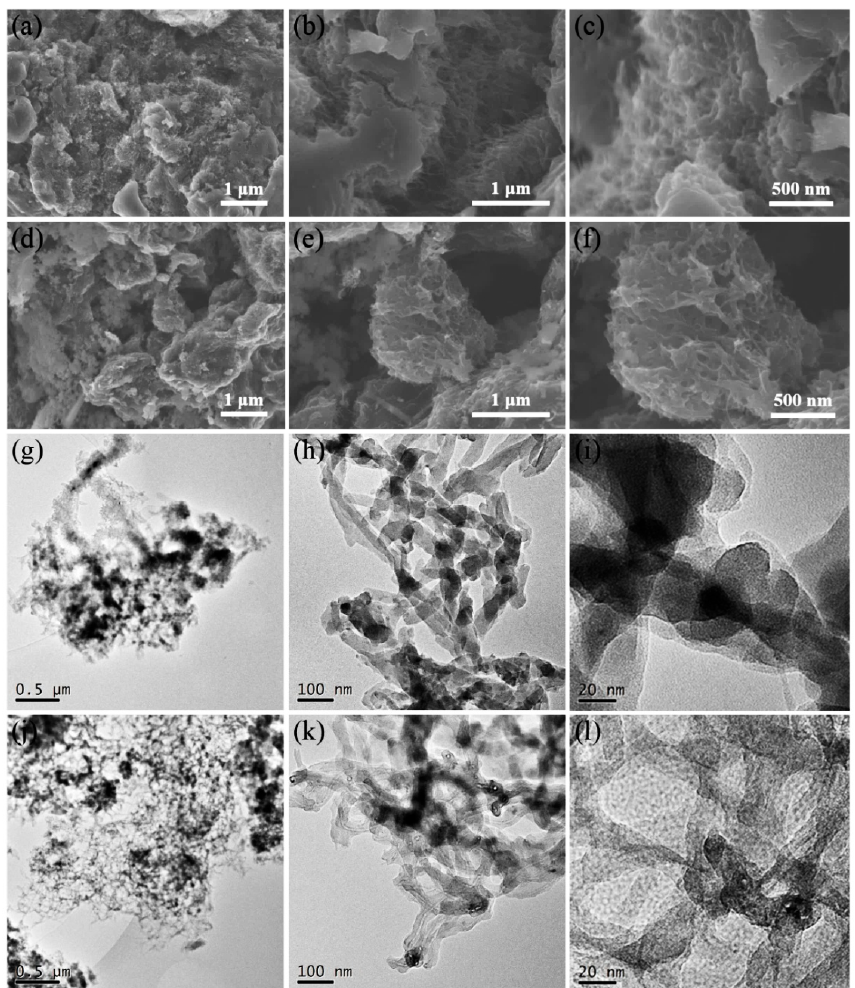
Figure 2. SEM images of ( a – c ) M/P-0.1 and ( d – f ) M/P-0.1-600-2 at different magnifications. TEM images of ( g –i) M/P-0.1 and ( j – l ) M/P-0.1-600-2 at different magnifications.